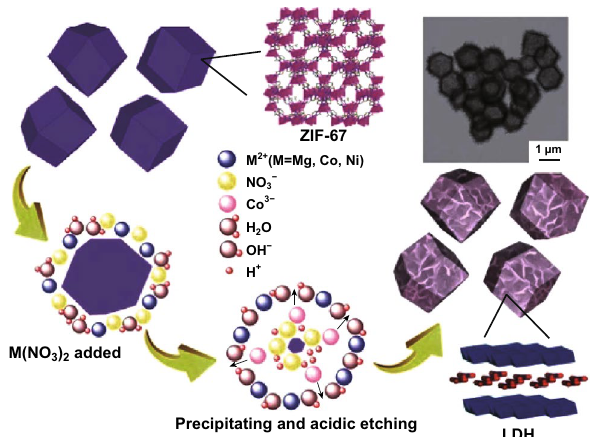
Fig. 5 The formation illustration of LDH nanocages by simultaneous precipitation and acidic etching. Reproduced from Ref. [48] with per‑ mission from The Royal Society of Chemistry